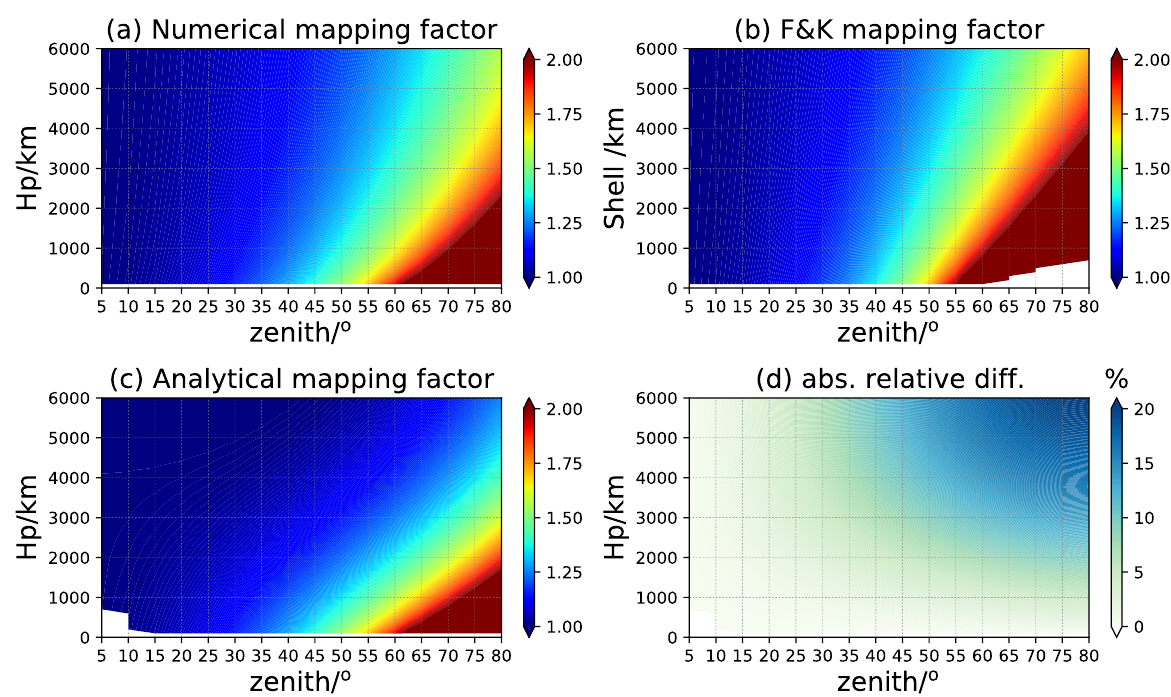
Figure 2. The mapping factor grid of zenith angle and the plasmaspheric scale height H P ; panel ( a , c ) are the numerical and analytical results of scale-height-based mapping function, respectively; ( b ) is those for F&K model; ( d ) is the absolute relative difference between ( a , c ).